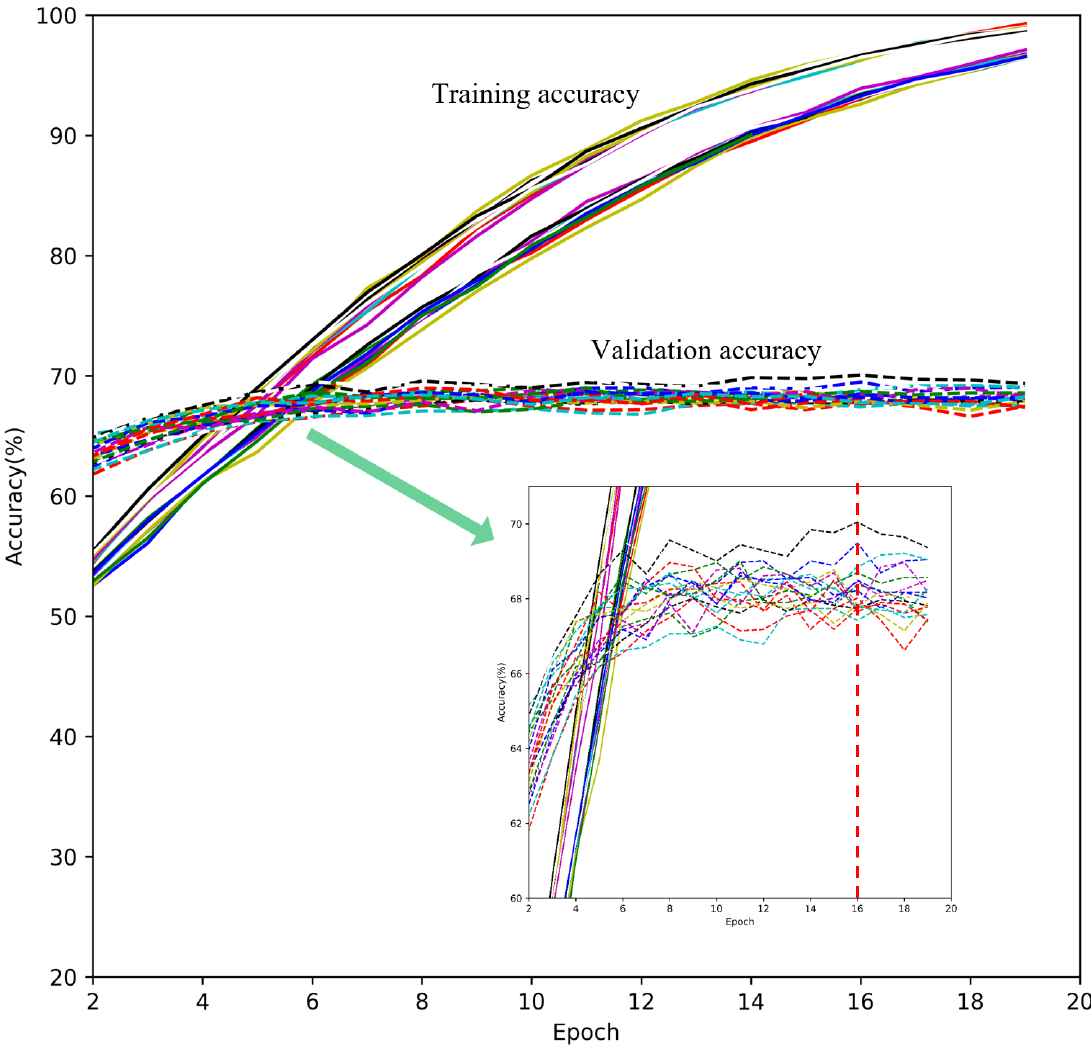
Figure 5. The accuracy progress for the 20 Inception-v3